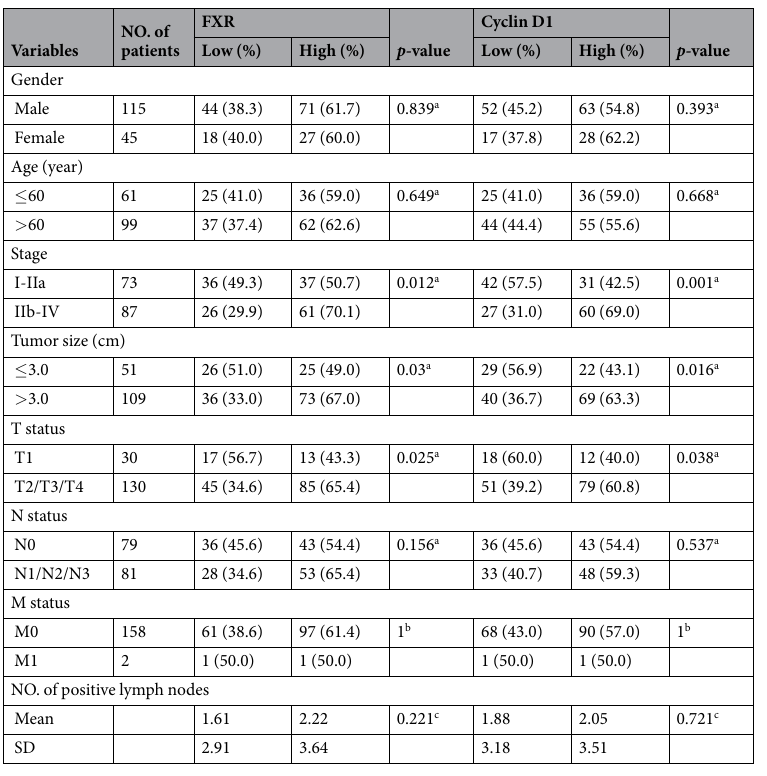
Table 2. Clinicopathologic characteristics according to FXR and cyclin D1 protein expression in NSCLC. a Data were analyzed using chi-square test. b Data were analyzed using Fisher’s exact test. c Data were analyzed using Mann-Whitney U